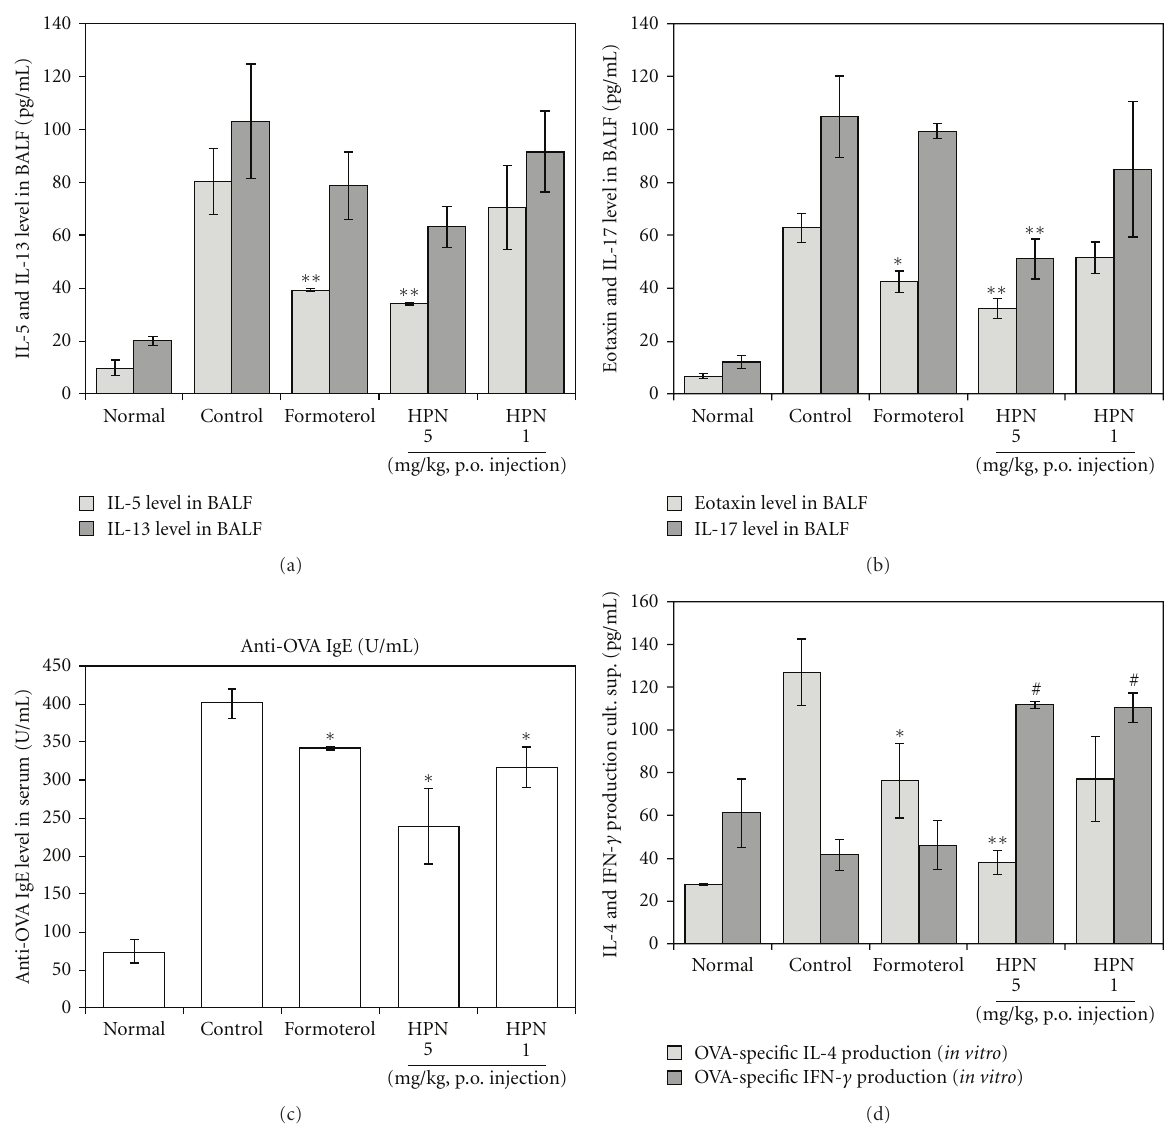
Figure 3: ((a), (b), (c)) E ff ect of HPN on Th2 cytokines (IL-5, IL-13), Th17 cytokine (IL-17), eotaxin in BALF, and OVA-specific IgE in serum. (d) Immunomodulatory e ff ects of HPN on OVA-specific Th1/Th2 cytokines production in spleen cells (described in Section 2). Results are expressed the mean ± S.E ( N = 5). Statistical significance between control and treatment groups was assessed by ANOVA ( ∗ P < . 05, ∗∗ P < . 01, significant increase; # P < . 05). N : normal BALB/c mice, CT: Ovalbumin inhalation+vehicle, formoterol: OVA + formoterol (1mg/kg), OVA + HPN (5,